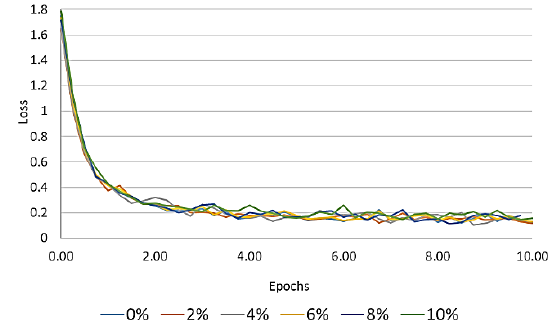
Figure 3. Loss evolution with different percentage of point cloud images in training set and online images in validation set.